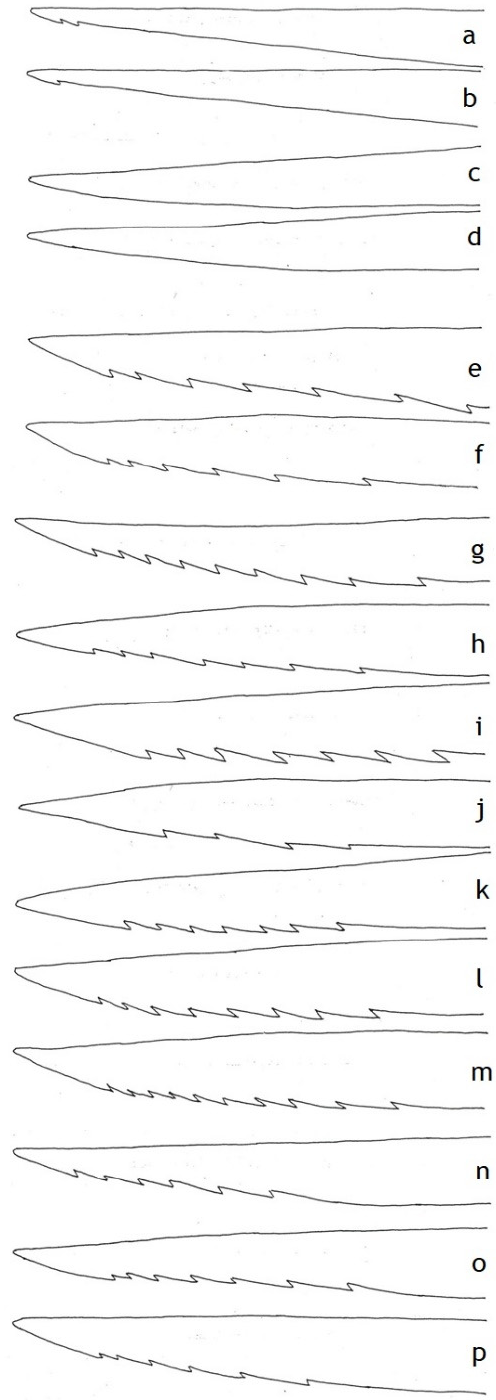
Figure 3. Terminal part of a sting lancet in vespid wasps in top or bottom view to illustrate the number and strength of barbs. Not all to the same scale. The bracketed number after each name is the serration index ( Sr ) defined in the text. ( a ) Pachodynerus sp. B (0.10). ( b ) Zethus sp. A (0.11). ( c ) Eustenogaster calyptodoma (0). ( d ) Parischnogaster striatula (0). ( e ) Polistes lanio (0.65). ( f ) Polistes versicolor (0.76). ( g ) Agelaia centralis (1.66). ( h ) Angiopolybia pallens (0.68). ( i ) Epipona tatua (2.27). ( j ) Parachartergus fraternus (0.54). ( k ) Polybia occidentalis (1.20). ( l ) Polybia rejecta (1.17). ( m ) Synoeca surinama (1.59). ( n ) Dolichovespula maculata (0.76). ( o ) Vespa bicolor (0.84). ( p ) Vespa ducalis (0.79).